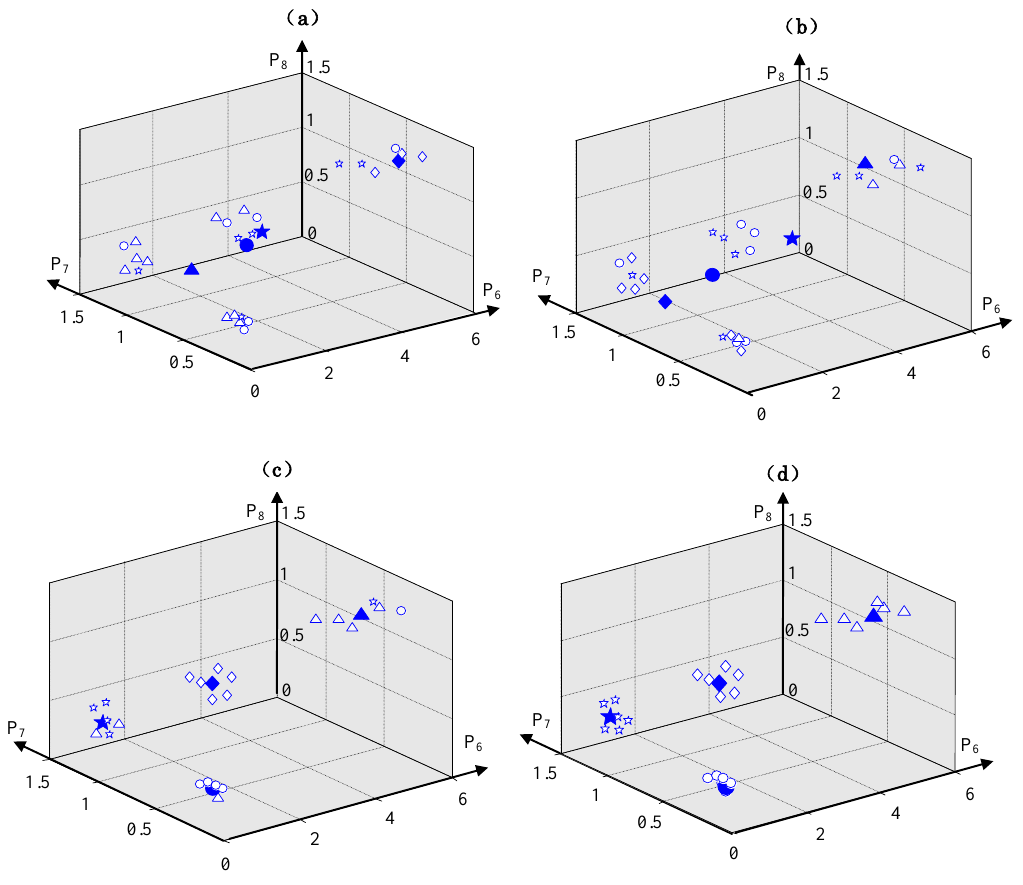
Figure 7. The change of the clustering centers while training the ACO for the condition diagnosis of the centrifugal fan. (a) At the start of the ACO, (b) after 50 iterations, (c) after 100 iterations and (d) after 150